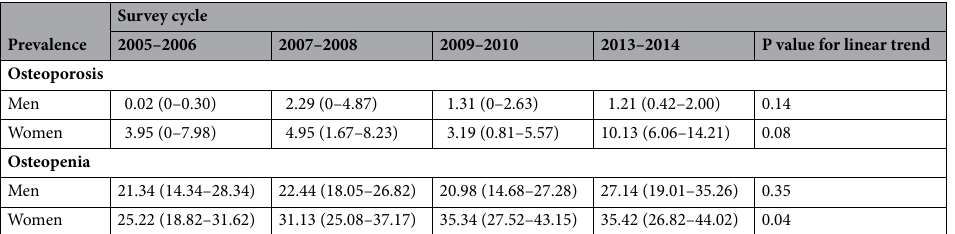
Table 3. Age- and BMI-adjusted prevalence of osteoporosis and osteopenia among T2DM patients stratified by gender in 4 NHANES (2005–2006, 2007–2008, 2009–2010, and 2013–2014).